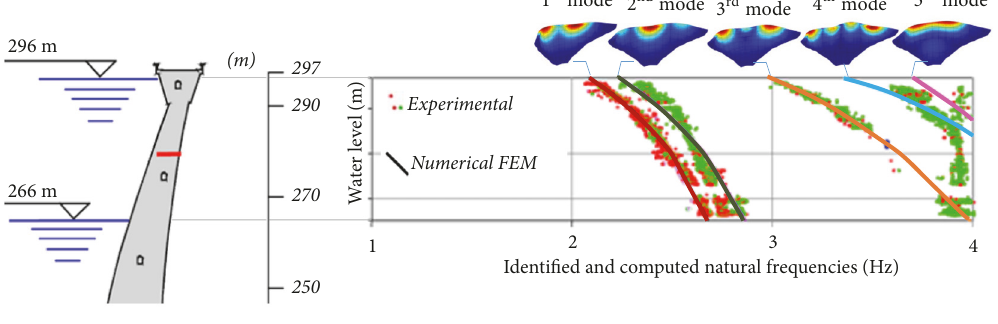
Figure 3: Variation of the main natural frequencies with the water level. Comparison between numerical and experimental values.